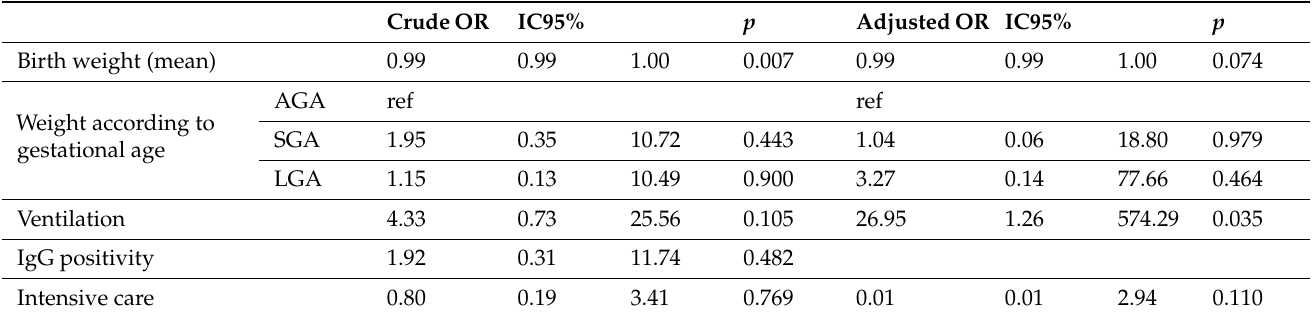
Table 5. Neonatal univariable and multivariable analysis of factors associated with symptomatic